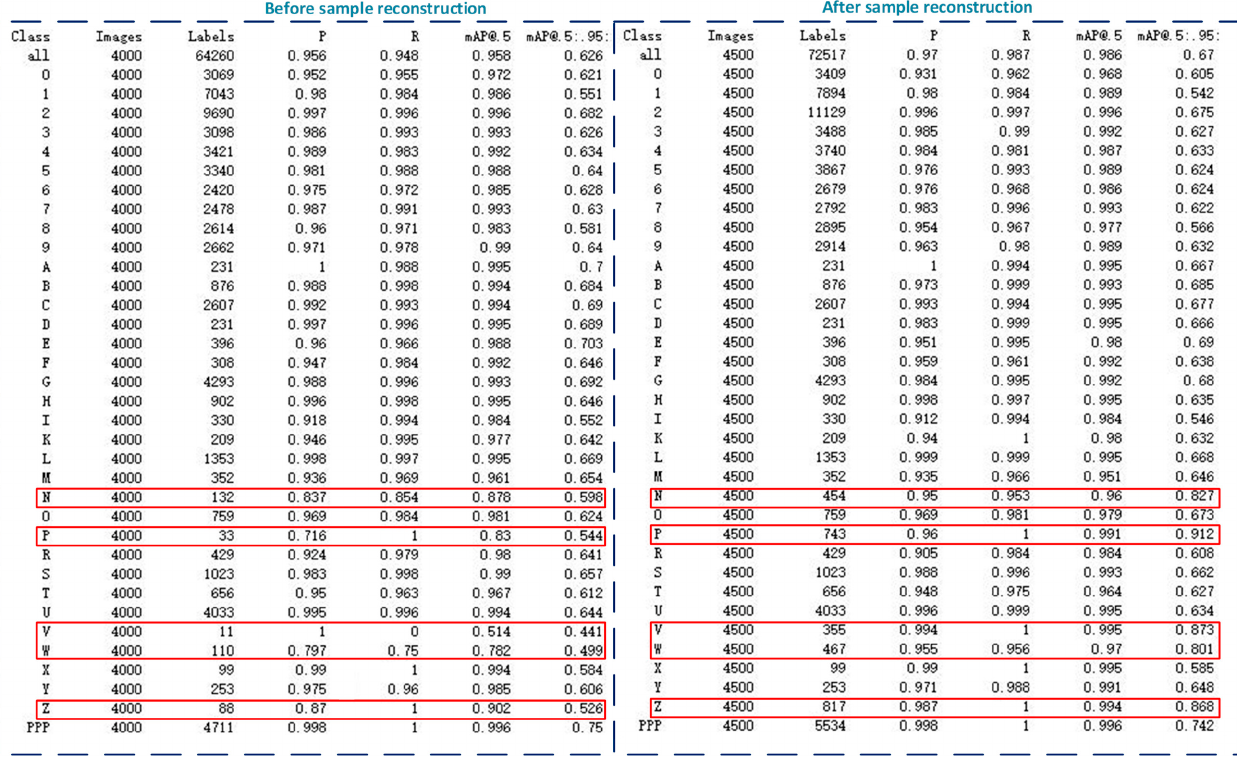
Figure A2. Some small sample character images after data reconstruction.